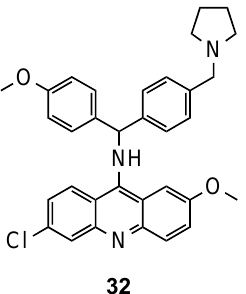
Figure 21. Compound 32 developed by Gemma and co-workers et al. [50].